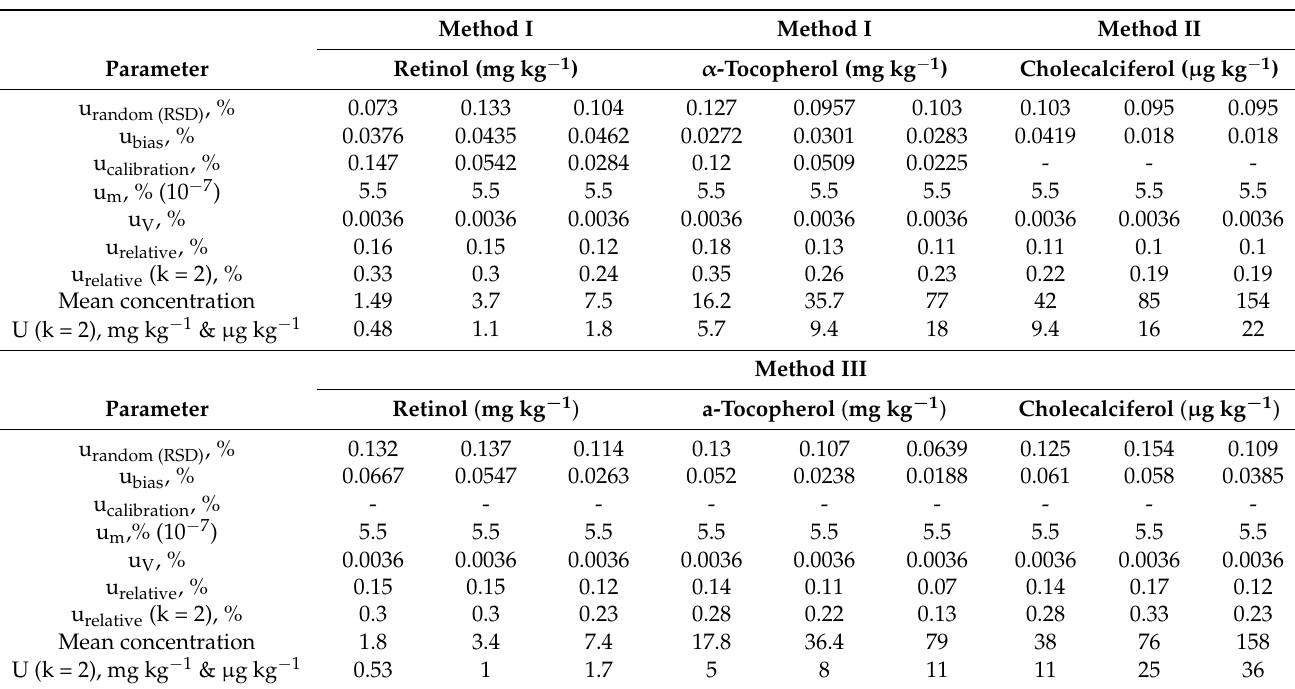
Table 10. Estimation of the uncertainty of each analyte.